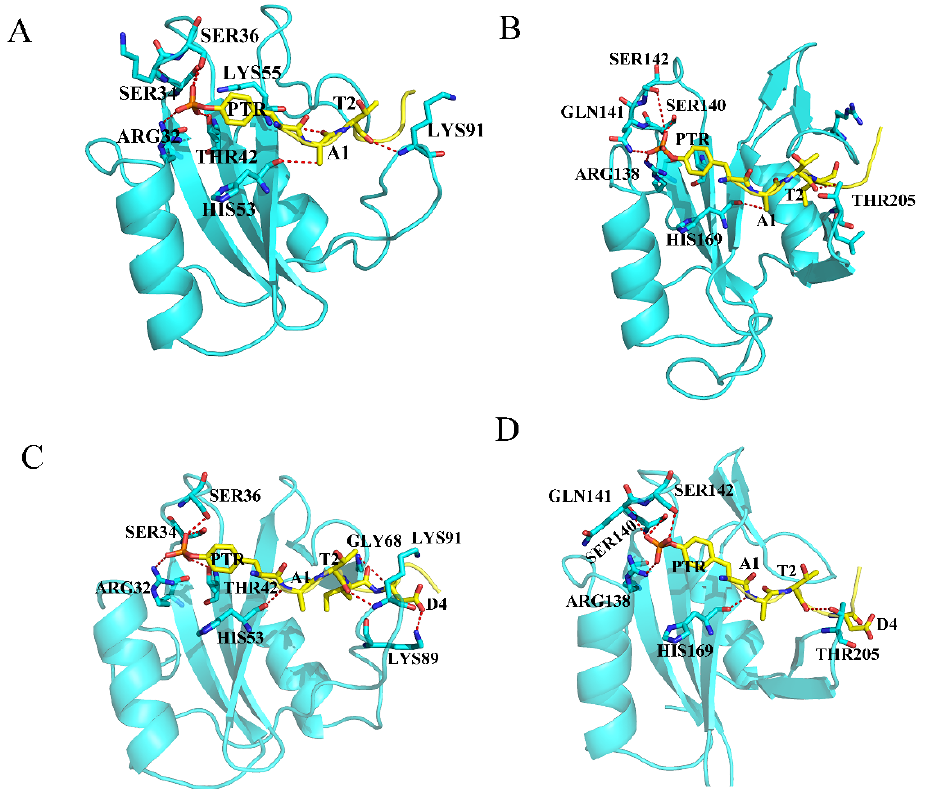
Figure 4. The hydrogen bonds between the SH2 domains and EPIYA in the systems EPIYA-D-N ( A ), EPIYA-D-C ( B ), EPIYA-C-N ( C ), and EPIYA-C-C ( D ). The residues on EPIYA peptides are identified by one letter (except PTR), and the residues on SHP2 are identified by three letters. The SHP2 protein is shown in blue, and the EPIYA peptides are re shown in yellow. The red dotted line means there is a hydrogen bond between the two residues.